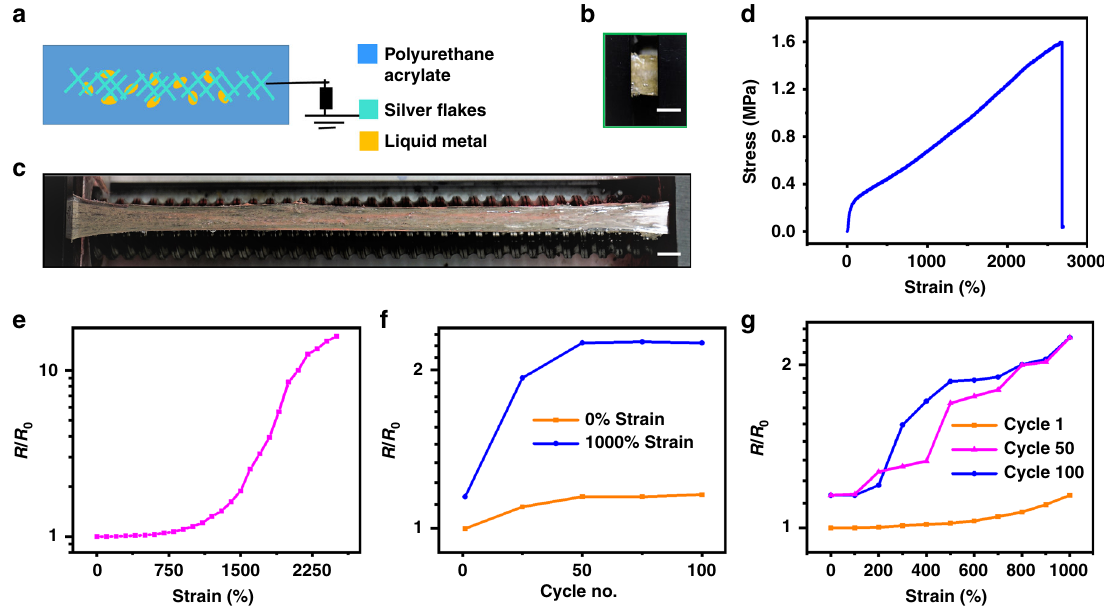
Fig. 2 Schematic diagram, digital photo, and mechanical and electrical properties. a Schematic diagram of the stretchable and healable triboelectric nanogenerator (SH-TENG). Silver fl akes and liquid metal particles are embedded in the polyurethane acrylate (PUA) matrix. Digital photo of the SH-TENG at strains of b 0% and c 2500%. Scale bar: 5 mm. d Tensile stress – strain behavior of the SH-TENG device. Deformation rate: 100 mm min − 1 . e Changes in resistance of the SH-TENG device at various uniaxial strains. R / R 0 is the relative resistance, where R 0 is the resistance of the conductor without strain and R is the resistance of the conductor with a certain strain. f Changes in resistance of the SH-TENG device for 100 cycles of uniaxial strain. g Changes in resistance of the SH-TENG device at various uniaxial strains measured for 100